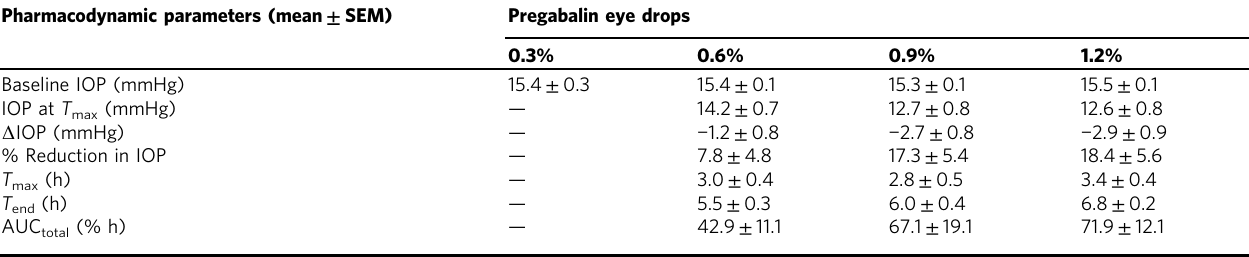
Statistical comparisons among four concentrations of pregabalin drops applied to the eyes of B6 mice Pharmacodynamic parameters (mean ± SEM)